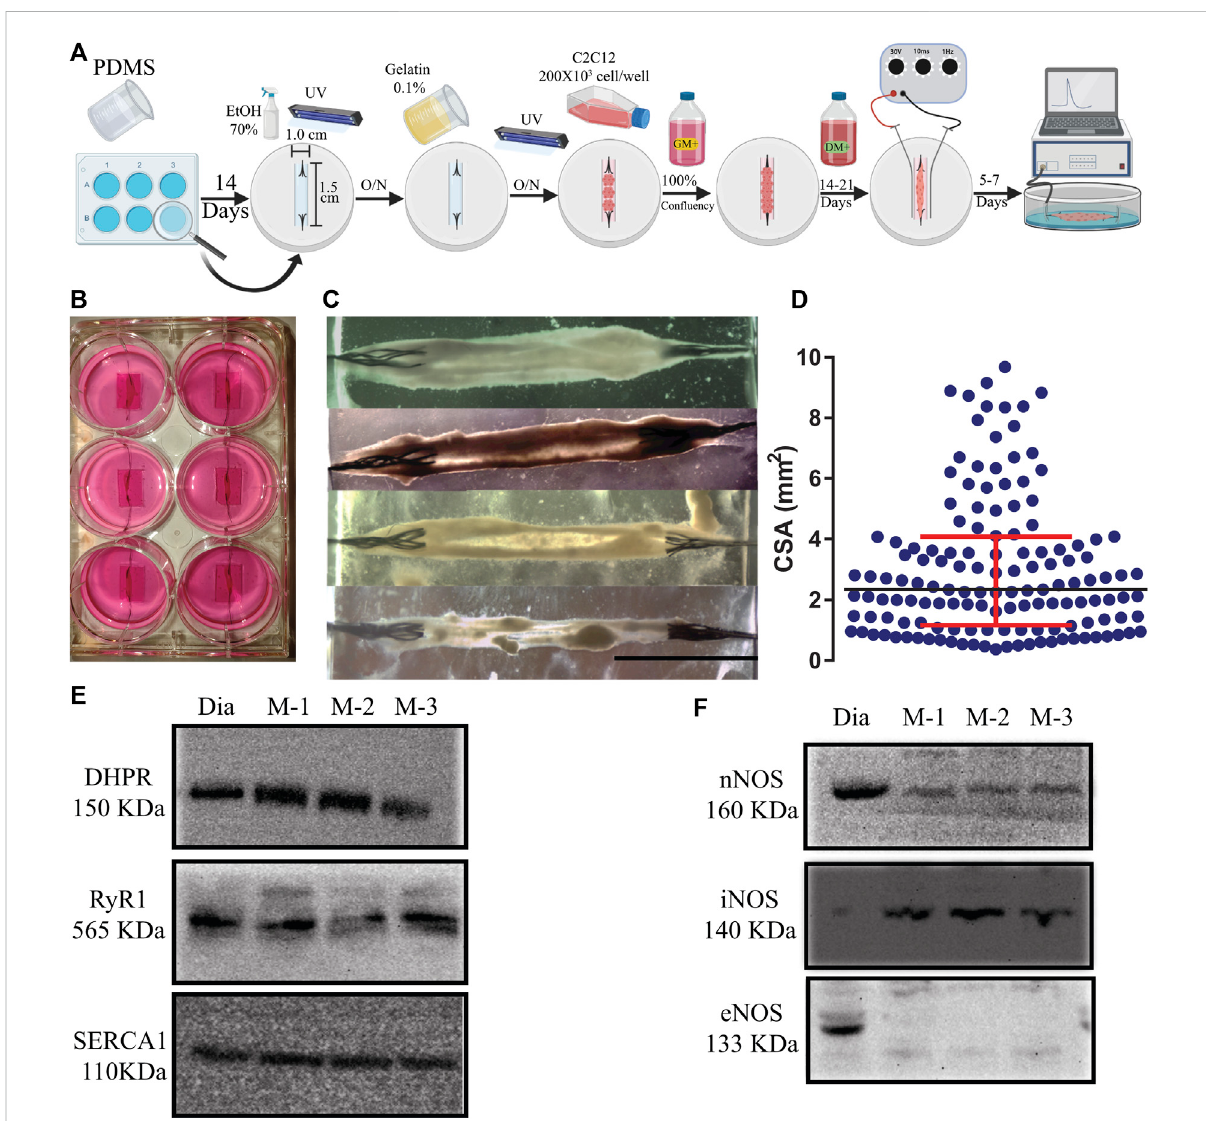
FIGURE 1 (A) .Schematicrepresentationofthe3Dtissue-engineeringofmyooidsfromtheC2C12cellline.Atimecourseisdescribedfromlefttoright(O/ N = overnight). Details of the protocol are described in Material and Methods. (B) Photography of a 6-well plate with six well-formed myooids after 21 days under differentiation medium. (C) Photomicrography of four different myooids just before setting them up on the force transducer. The bar represents 0.5 cm. (D) Data analysis with the representation of the cross-sectional area of 180 myooids analyzed in this study. E and (F) Images of six immunoblottings from diaphragm muscle (Dia) and three different pools of fi ve myooids each (M-1, M-2, and M-3). The molecular weight is described under the abbreviation of the name of each protein. (E) Immunoblotting images for DHPR, RyR1, and SERCA1. (F) Immunoblotting images for nNOS, iNOS, and